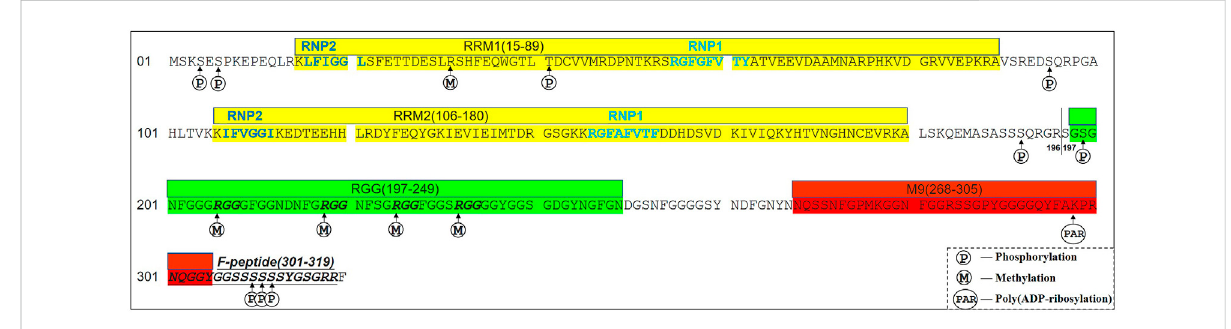
FIGURE 1 A scheme of the hnRNP A1 primary amino acids sequence (UniProt:P09651-2). The amino acids (1 – 196) are the N-terminus (also named UP-1) of hnRNP A1, consisting of two RNA recognition motifs (RRM1 and RRM2, Yellow). The amino acids sequences of dark gray are the C-terminus (also named GRD,197 – 320), composed of RGG (197 – 249, Green) with four RGG motifs (Italic Bold), M9 (268 – 305, Red) and F-peptide (301 – 319, Italic Underline). The phosphorylation and poly (ADP-ribosylation) sites of hnRNP A1 are